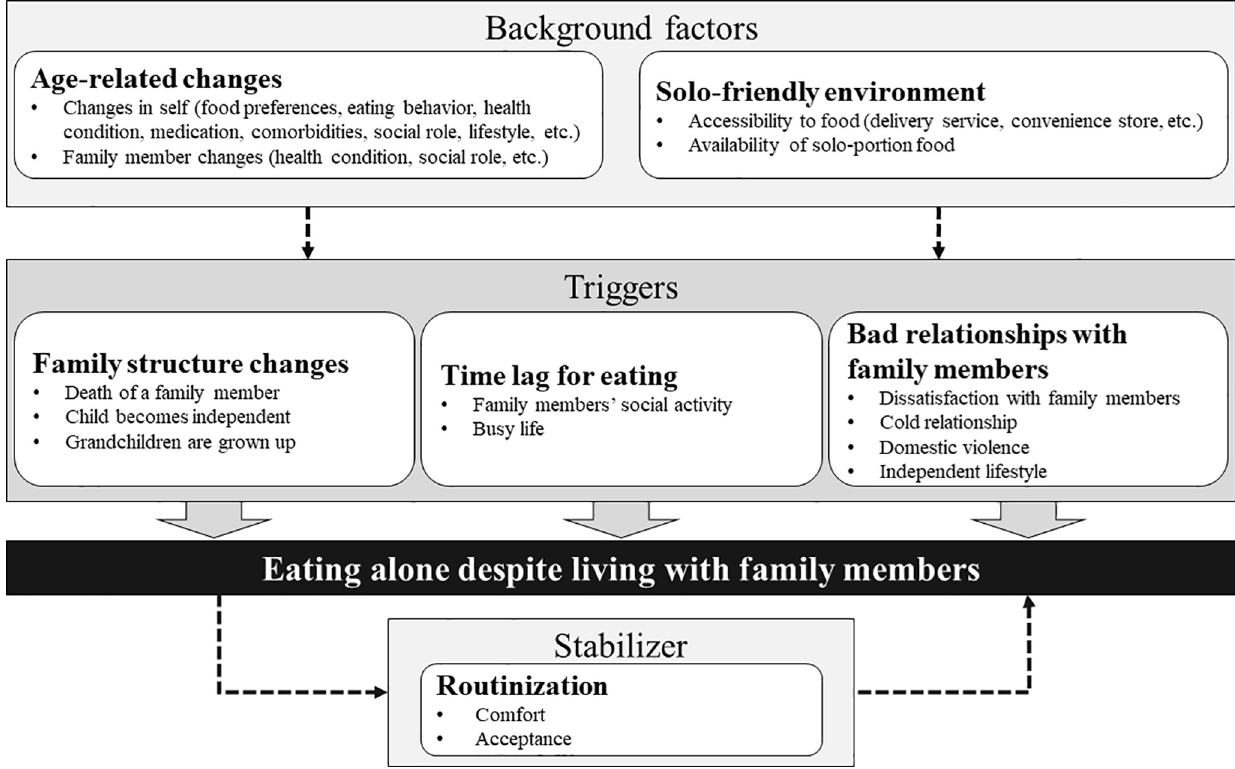
Fig 2. Background factors, triggers, and stabilizer for eating alone despite living with family members.